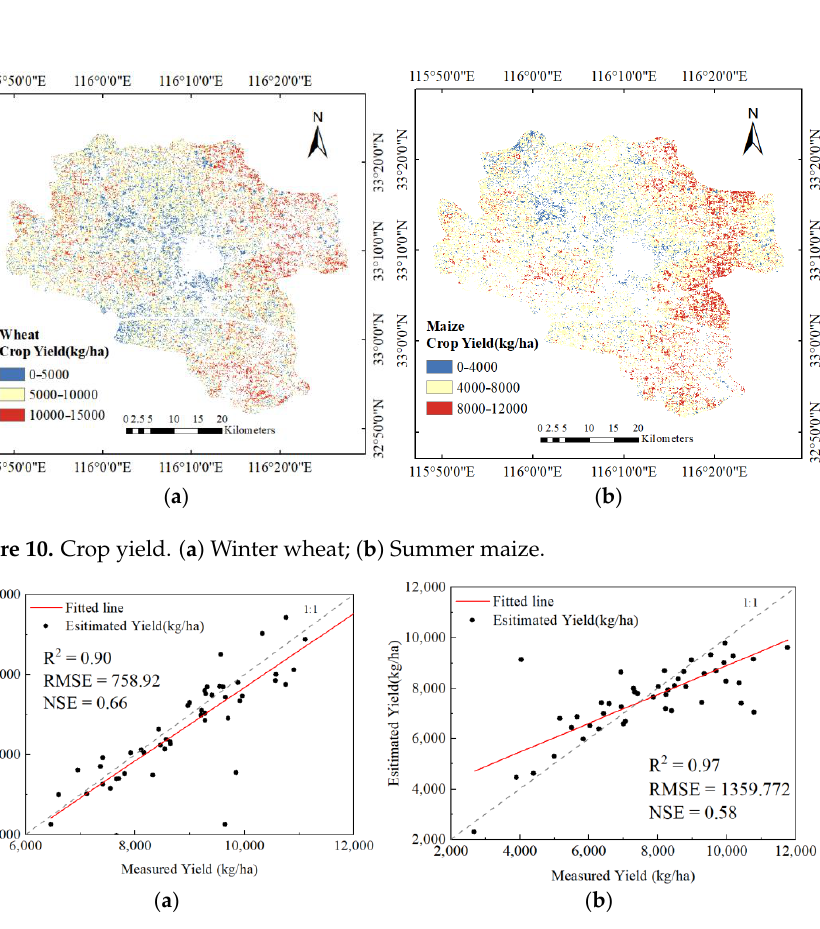
Figure 11. Validation of the estimated crop yield. ( a ) Winter wheat; ( b ) Summer maize.